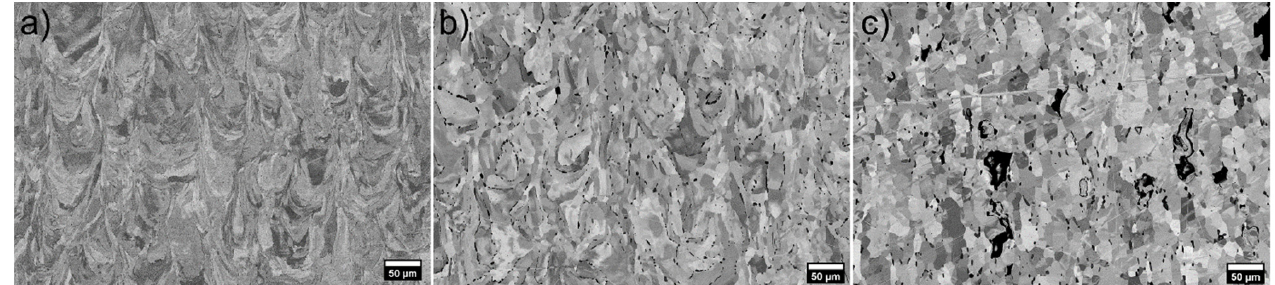
Figure 10. ( a ) SEM image of the heat-treated sample used for creep tests. ( b , c ) Show images after the creep tests in a region without and with load, respectively.